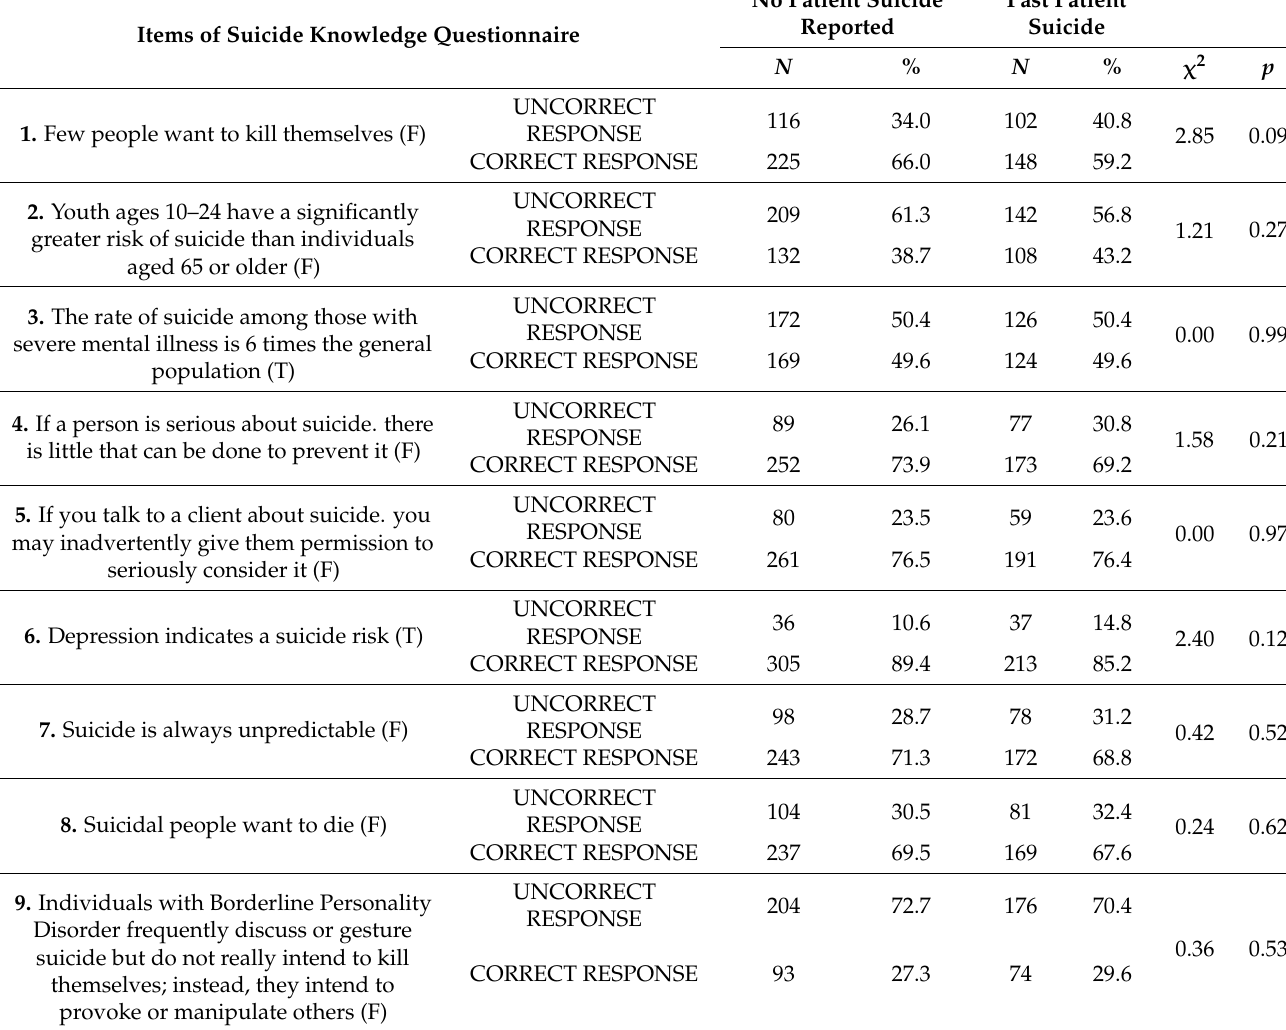
Table 3. Suicide knowledge by experience with a